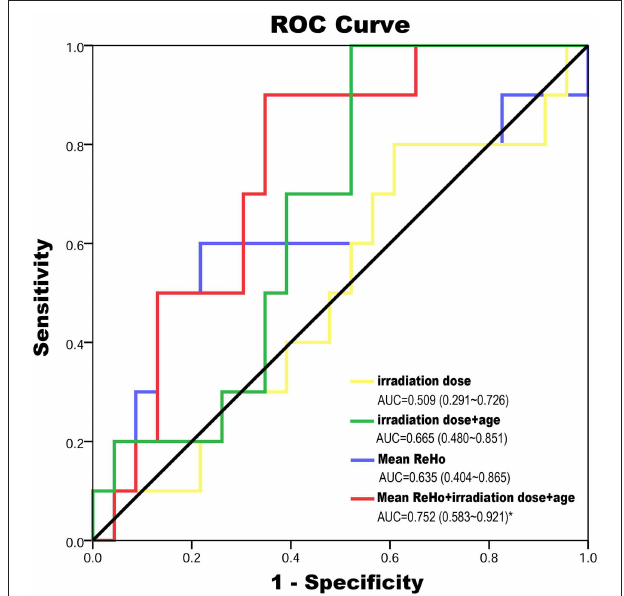
FIGURE 4 | The ROC curves for mean ReHo (showed groups differences) at EDS, age, dose (the maximum irradiation dose to bilateral temporal lobe) alone and three combined model were qualified to determine the efficacies of predicting of impaired cognitive function in LDS. The multivariate regression analysis showed that the logistic regression model combining the three variables has the highest diagnostic efficiency according to the AUC score of the ROC curves (AUC = 0.752, P = 0.023). AUC, area under the curve; EDS, early-delayed stage; LDS, late-delayed stage; ReHo, regional